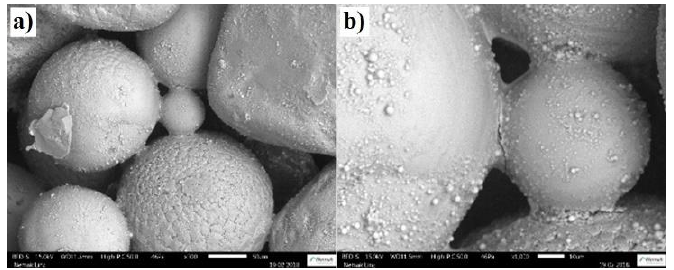
Figure 15. SEM pictures of bonded sand C, ( a ) ×500 and ( b ) ×1000, with a visible cohesive broken binder bridge.